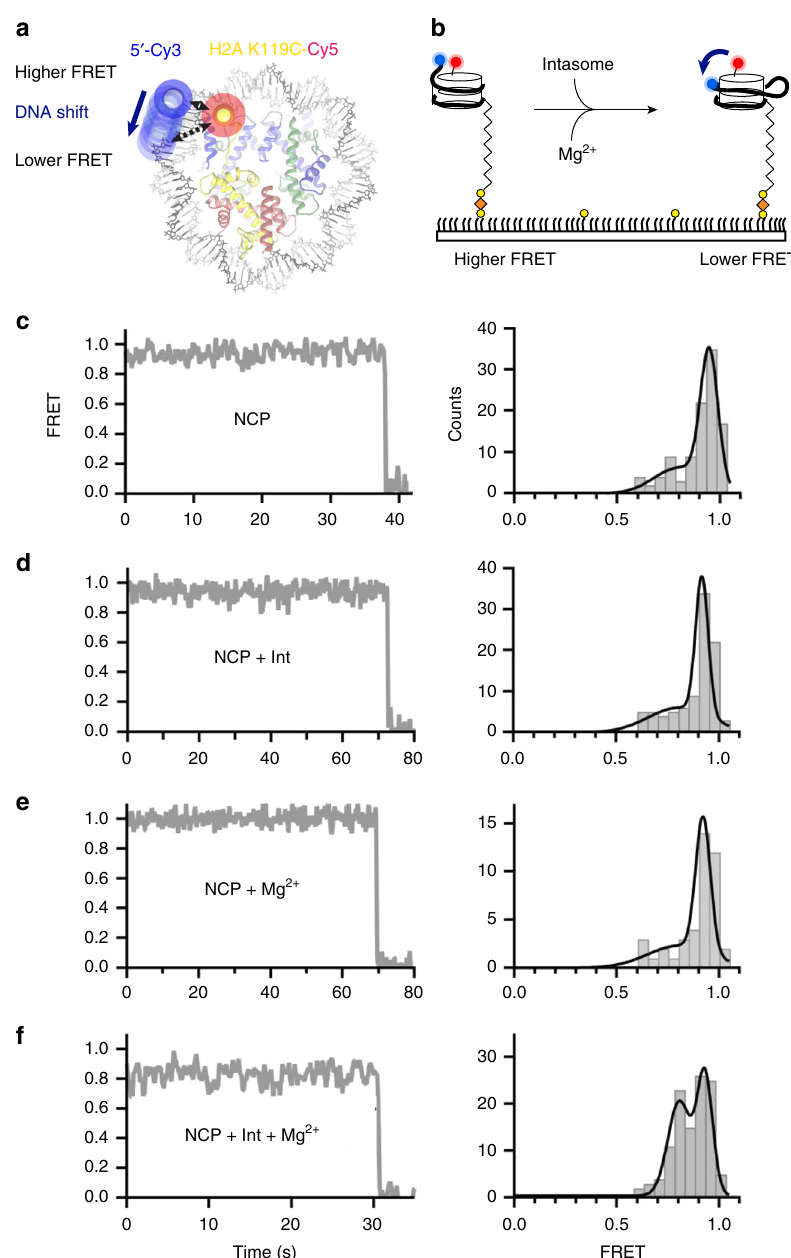
Fig. 5 Integration-promoted nucleosomal DNA sliding observed by single molecule FRET. a Fluorescently labelled NCP: labelled octamer ( Cy5 on H2A, red) wrapped with biotinylated labelled DNA ( Cy3 on exit site, blue). b NCPs are surface-immobilised on neutravidin (orange) coated biotin-PEG (yellow) slides. Intasome-induced translocation in the presence of magnesium is detected as a FRET decrease. Representative single-molecule FRET trajectories (left) and histograms (right) of proximal-only labelled NCPs c without intasome or magnesium ( N = 105), d in the presence of intasome ( N = 93), e in the presence of magnesium ( N = 42), and f in presence of both intasome and magnesium ( N = 115). A signi fi cant population shift to ~ 0.8 FRET in the presence of both intasome and magnesium. Data were collected at 100 ms/frame (10 Hz) and smoothed with a 3-point moving average. Black lines in